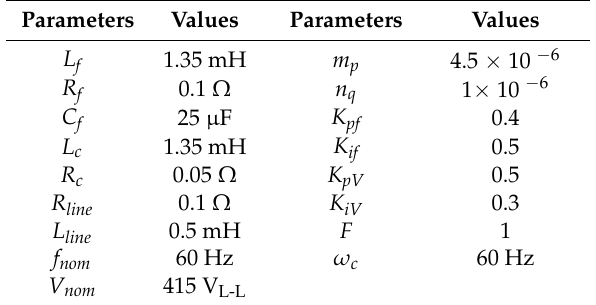
Table 1. System parameters for microgrid control.